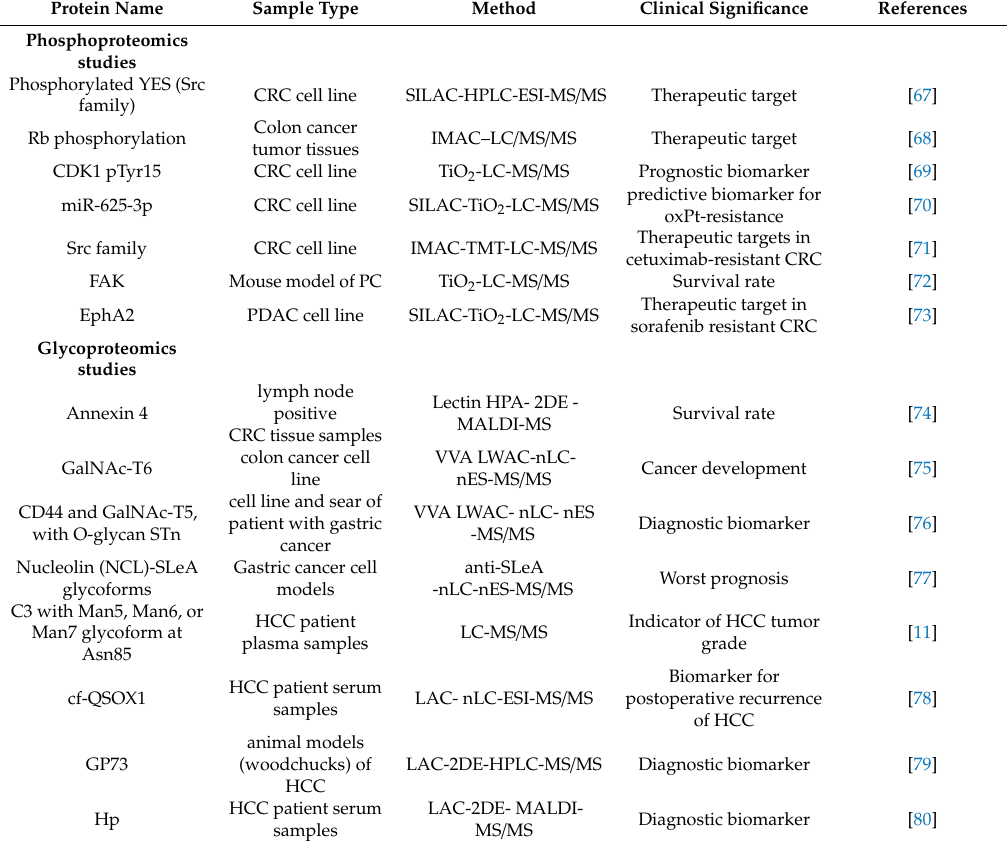
Table 2. Summary of selected biomarkers for GI